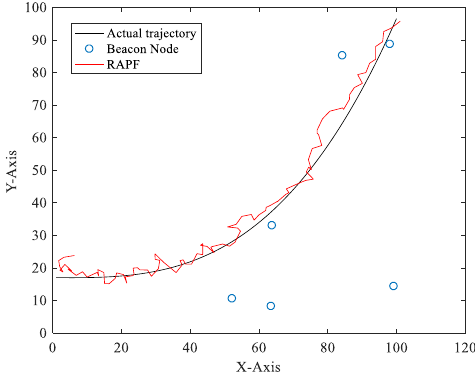
Figure 4. The localization result of RAPF.